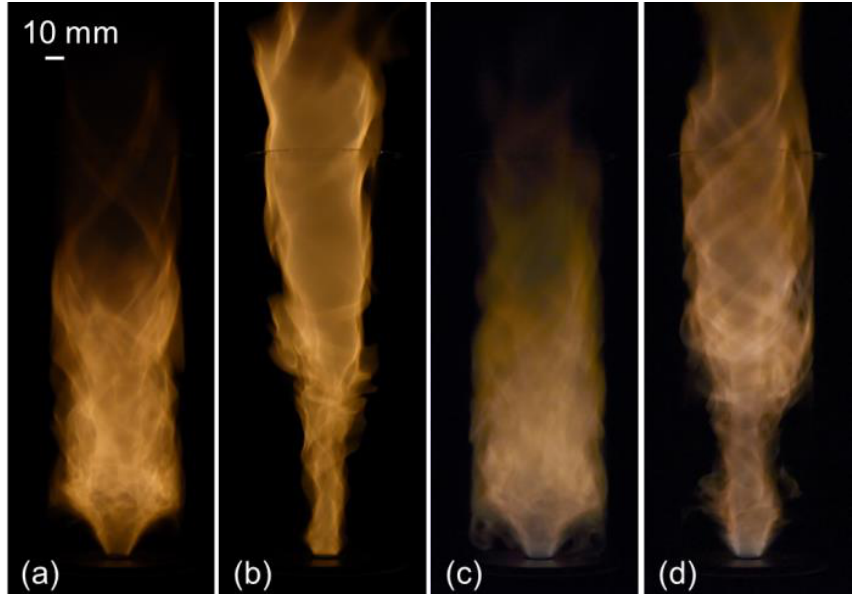
Figure 9. Direct visualization of ( a ) a pure ammonia flame at Φ = 0.78 and a bulk velocity of 6.8 m/s, ( b ) a pure ammonia flame at Φ = 0.70 and a bulk velocity of 8.5 m/s, ( c ) a 10% ammonia cracking flame at Φ = 0.62 and a bulk velocity of 6.8 m/s, and ( d ) a 10% ammonia cracking flame at Φ = 0.55 and a bulk velocity of 8.5 m/s.